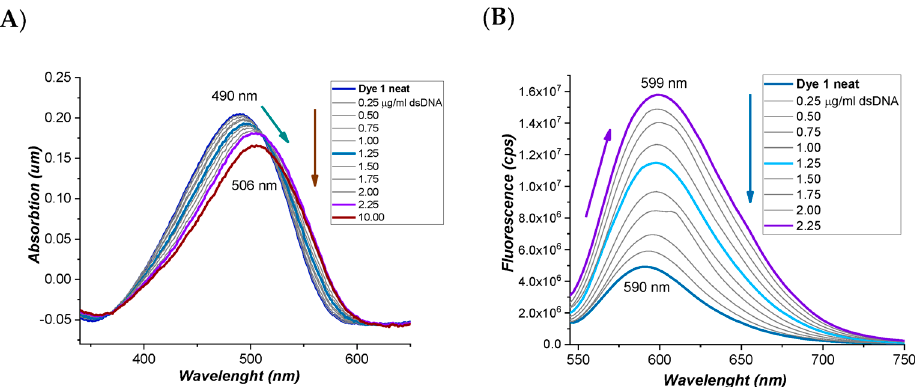
Figure 1. ( A ) Absorption spectra of dye 1 in TE buffer neat and in presence of dsDNA; ( B ) Fluores- cence spectra of dye 1 in TE buffer neat and in presence of dsDNA.